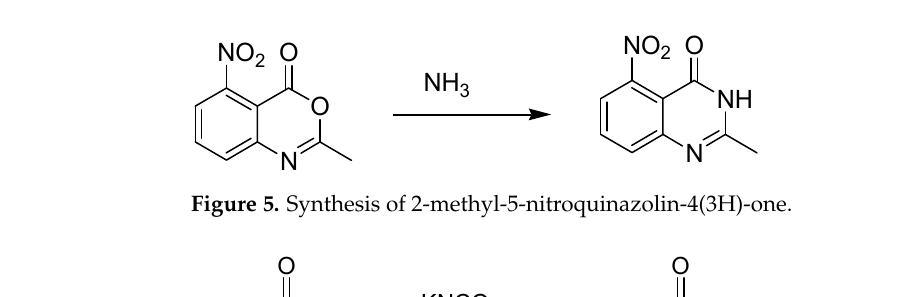
reacted to get o-ureidobenzoic acid followed by cyclization by heating with acid or